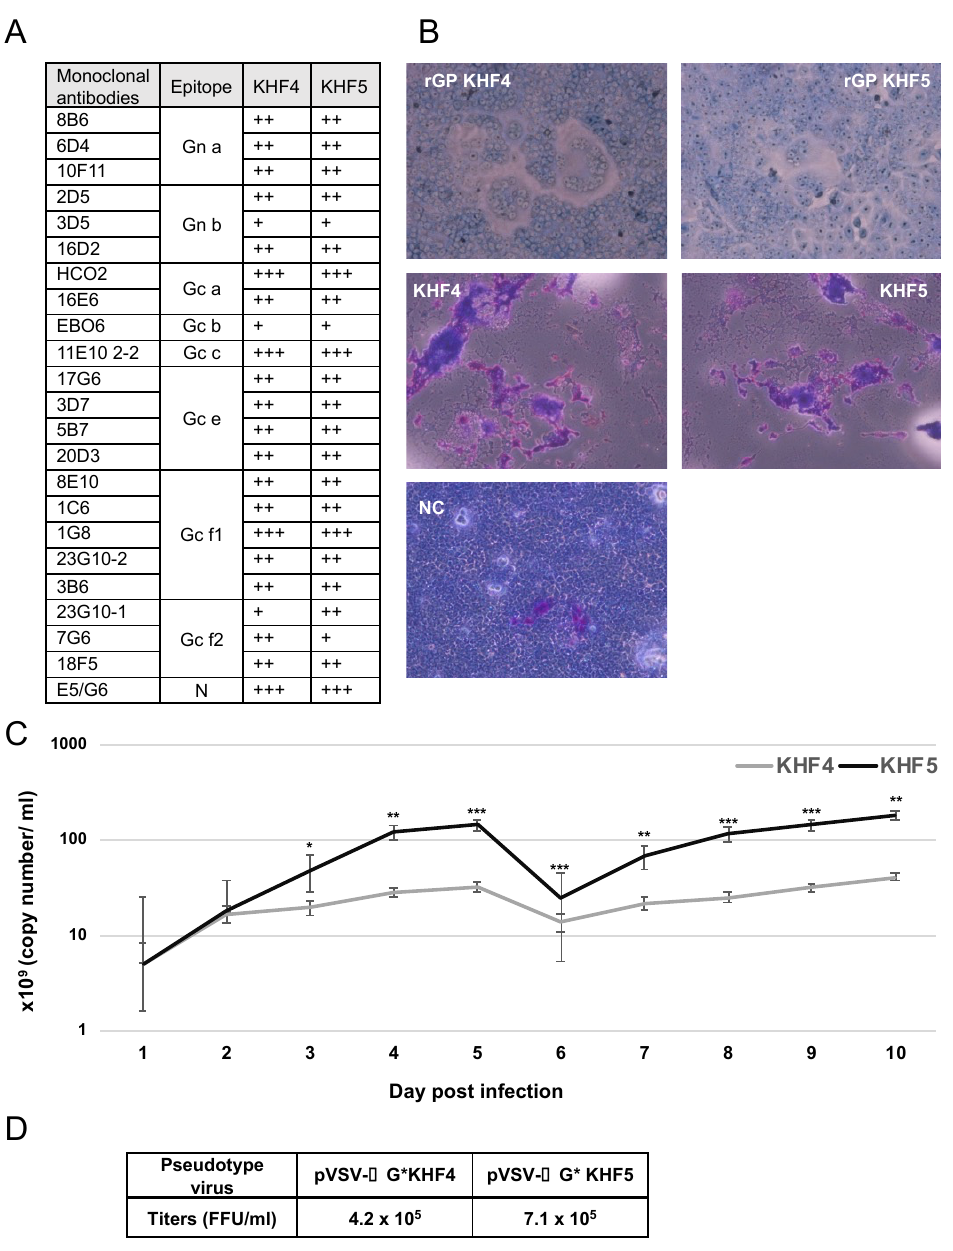
Figure 1. Virological characterization of KHF4 and KHF5. ( A ): GPs of KHF4 and KHF5 were compared for monoclonal antibody binding. The culture supernatants of hybridoma of monoclonal antibodies were diluted 1:1, 1:10, and 1:100, and positivity in the 1:100, 1:10, and 1:1 dilutions was assessed as +++, ++, and +, respectively. ( B ) Cell fusion assay. Cell fusion activity of recombinant glycoproteins of KHF4 and KHF5 expressed in Vero E6 cells by transfection (upper panels). Fusion activity of Vero E6 cells infected with KHF4 and KHF5 (central panels). Cells were inoculated with viruses at a MOI of 0.1 and incubated for 5 days. Uninfected Vero E6 cells were used as negative controls (NC; lower panel). ( C ) Viral growth in Vero E6 cells. Culture supernatant was collected from cells between 1 to 10 dpi, and the viral load was quantified by real-time RT-PCR (Significance was assigned as * p < 0.05, ** p < 0.01, and *** p < 0.001). ( D ) Pseudotype VSV with KHF4 and KHF5 glycoproteins were transfected to HEK293T cells and the propagated pseudotype VSV and titers were determined in Vero E6